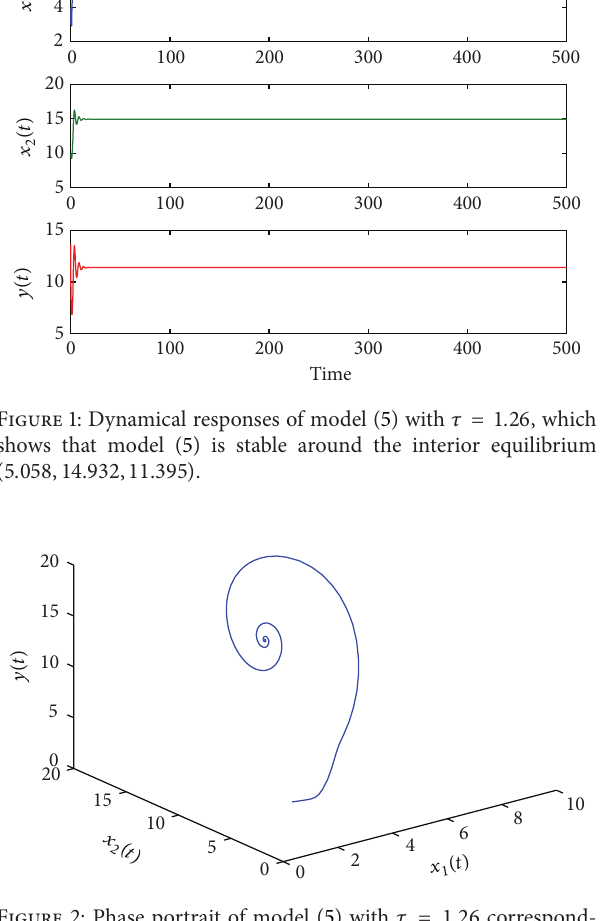
Figure 4: A limit cycle corresponding to the stable periodic solutions plotted in Figure